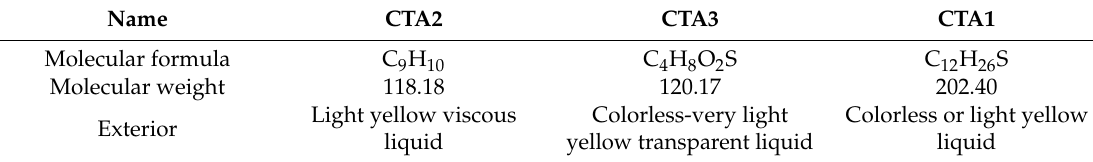
Table 1. Physical properties of transfer agents used in this work.